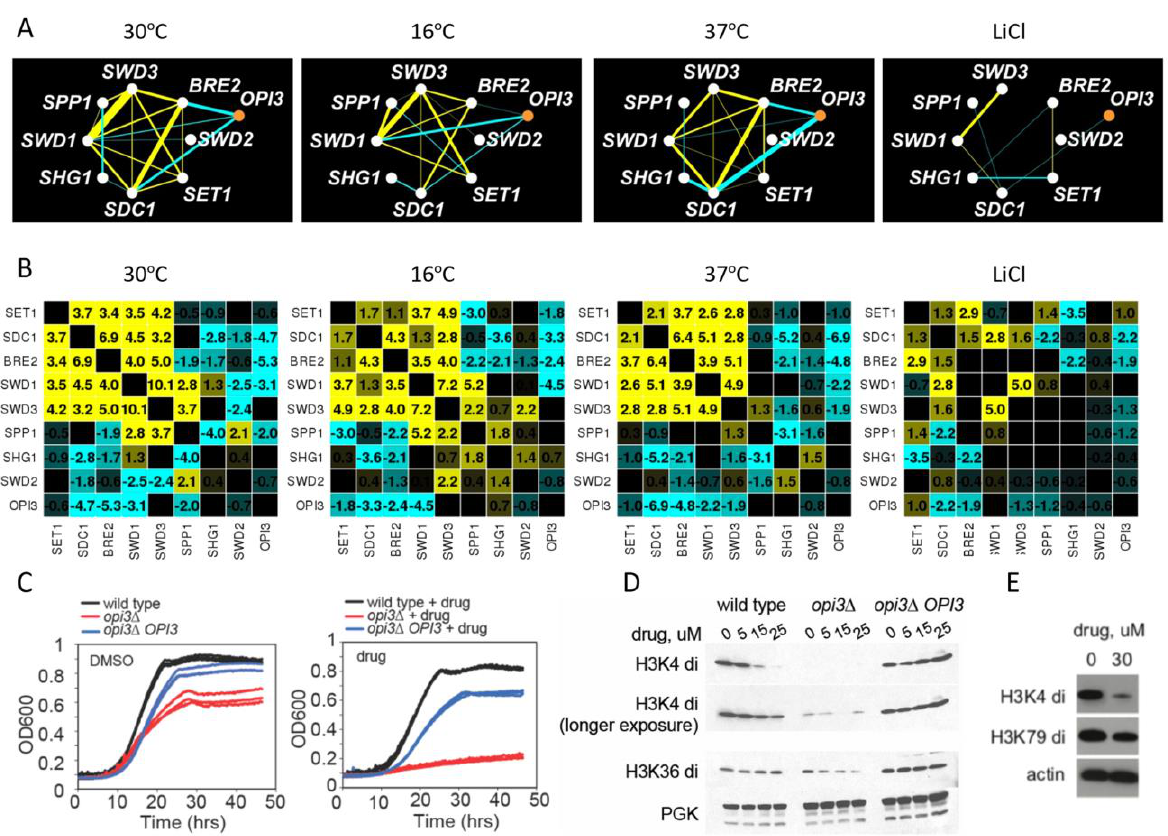
FIGURE 7: Exploring COMPASS and phospholipid MT connection. (A) Genetic interactions among COMPASS MTs and OPI3. Yellow; positi- ve genetic interaction, cyan; negative genetic interaction. (B) Genetic interactions among COMPASS MTs and other genes in the four stress conditions. Yellow; positive genetic interaction, cyan; negative genetic interaction. (C) Overexpression of OPI3 rescues the drug-induced fitness defect opi3 Δ in the presence and absen ce of the opi3 Δ chemical probe. Growth of wild-type, opi3 Δ and opi3 Δ overexpressi ng OPI3, without drug (left panel) and with drug (right panel). Growth is measured by as O.D.600 (y-axis) as a function of time (hrs)(x-axis). (D) OPI3 is important for histone methylation. Levels of di-methylated H3K4 and H3K36 in the indicated strains and drug conditions. (E) Levels of di- methylated H3K4 and H3K79in in A549 cell in response to 30μM opi3 Δ chemic al